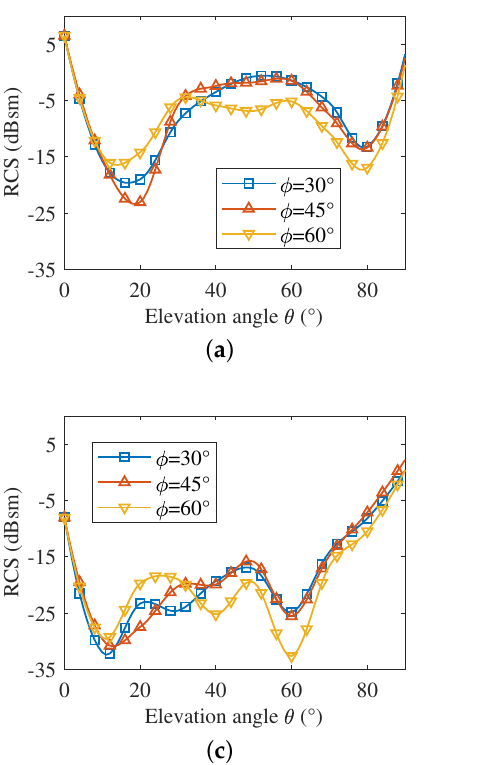
Figure 9. RCS comparison of two corner reflectors at 11 GHz. ( a ) Traditional corner reflector. ( b ) Electrically controlled corner reflector with 5000 Ω resistance. ( c ) Electrically controlled corner reflector with 1.5 Ω